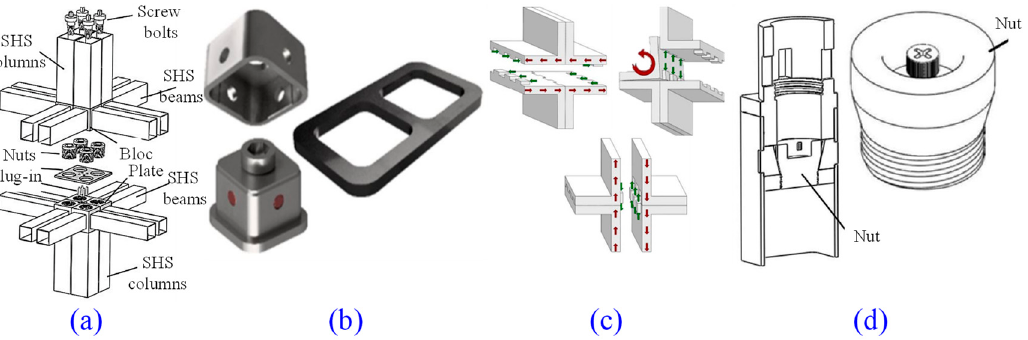
Figure 4. Detachable IMC. ( a ) screw bolted [70]; ( b ) auto-pin screw [77,78]; ( c ) beams sawed [79]; and ( d ) pinned bolted [76] IMC.